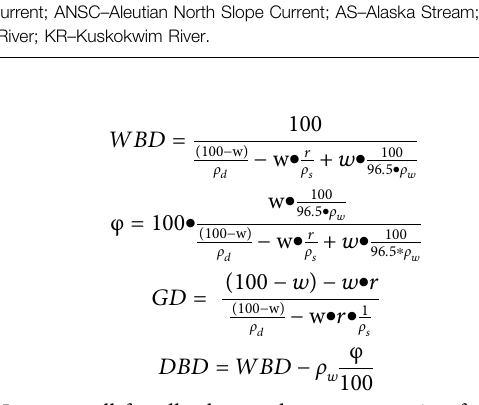
Frontiers in Earth Science |